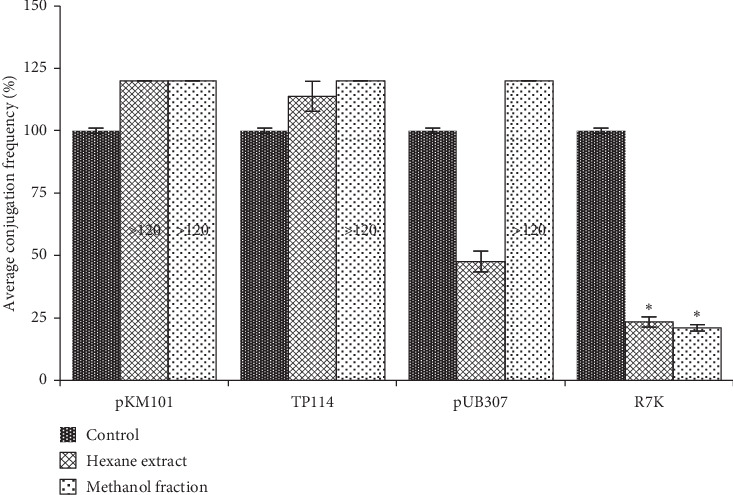
The effect of hexane extract and methanol fraction of M. lowiana on the conjugal transfer of plasmids pKM101 (IncN), TP114 (IncI2), pUB307 (IncP), and R7K (IncW), expressed as a percentage relative to a control (without extract). The extracts were tested at subinhibitory concentrations, 100 mg/L. ∗p < 0.05 (means significantly different from control).